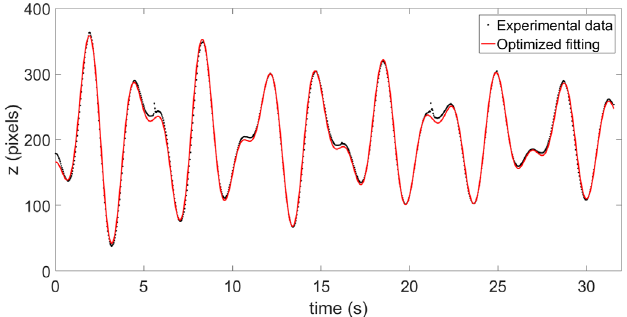
Fig. 9. Experimental data and optimized fi tting of z ( t ).